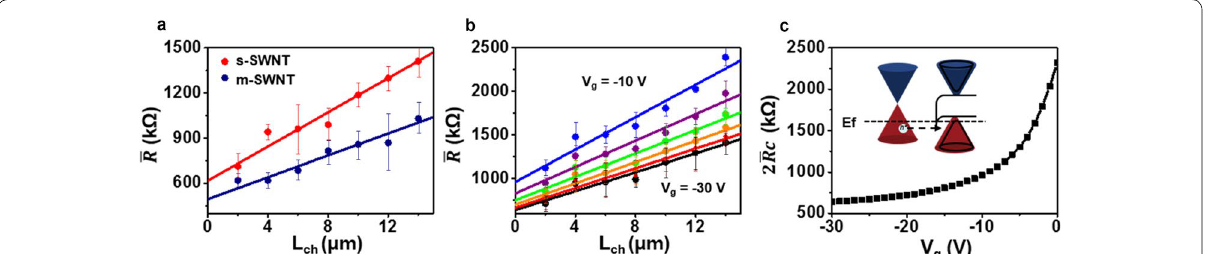
Fig. 3 L ch scaling and extracted contact resistance. a The average resistance of the m-SWCNTs and s-SWCNT as a function of L ch at gate voltages of 0 V (m-SWCNT) and 30 V (s-SWCNT), respectively. b The average resistance of the s-SWCNT as a function of L ch , varying the back-gate from − to 10 V with steps of 4 V. c The extracted contact resistance of the s-SWCNTs as a function of gate −